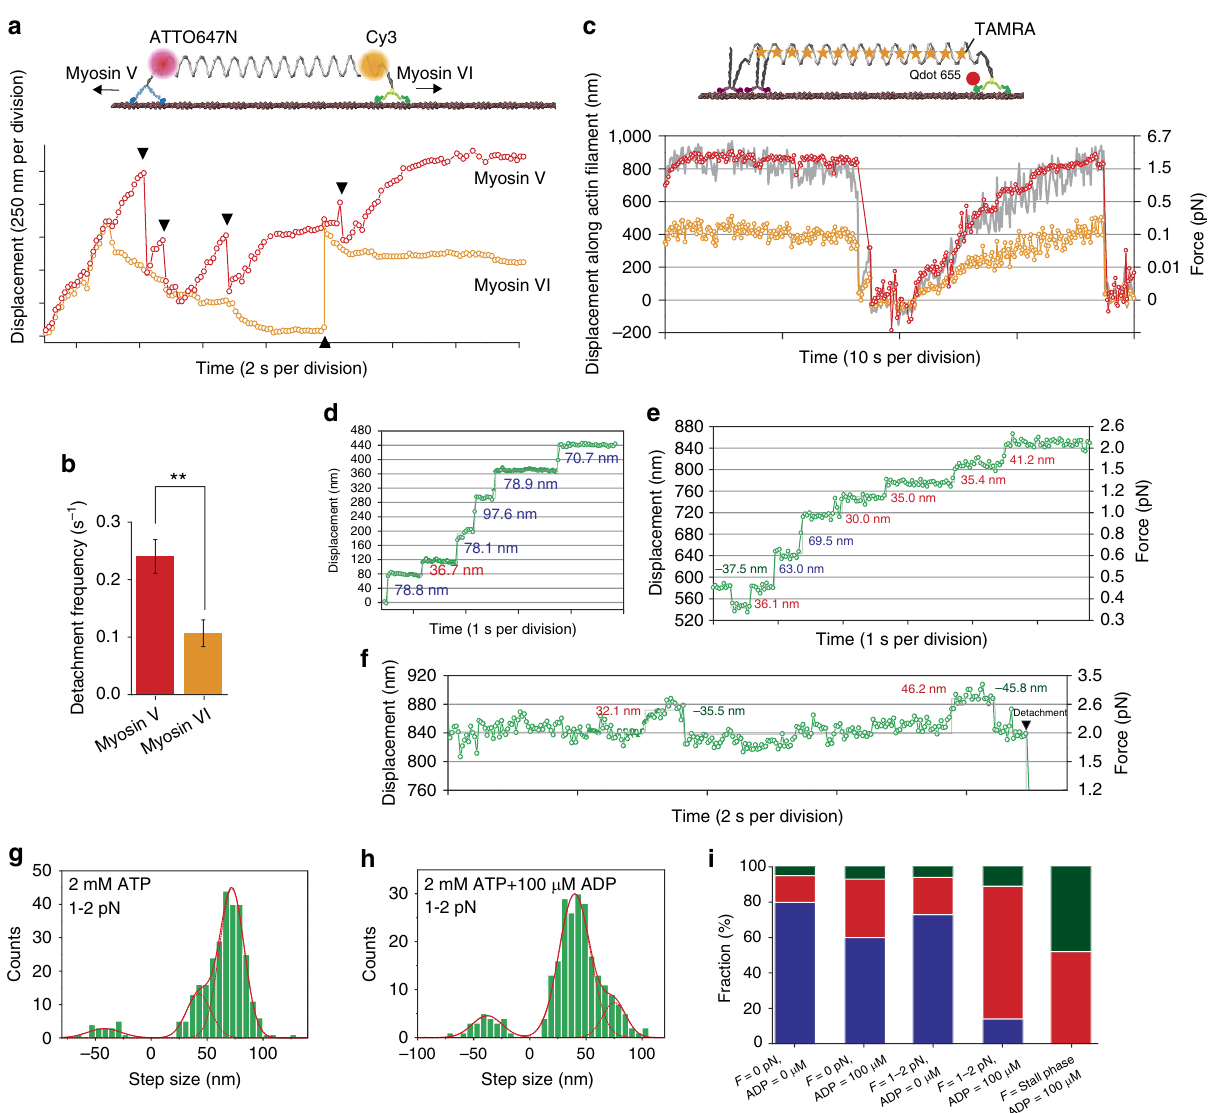
Figure 3 | Dual colour imaging of single-molecule tug-of-war and nanoimaging of myosin VI head domain under load. ( a ) Typical trajectory for dual colour imaging of tug-of-war between myosin V and VI at 2mM ATP þ 100 m M ADP. Red circles, the ATTO647N position, which indicates myosin V motion; orange circles, the Cy3 position, which indicates myosin VI motion. Black triangles indicate detachment events. ( b ) Detachment frequency during tug-of-war for myosin V (red) and myosin VI (orange). Error bars indicate s.e.m. N ¼ 47 myosin-NS complexes, ** P o 0.01 (two-sided t -test). ( c ) Trajectories of a QD (red circles) attached to the head of a myosin VI, the centre position of a TAMRA nanospring (orange circles) and two times the displacement of the centre position of the TAMRA nanospring (grey line) at 2mM ATP þ 100 m M ADP. Recording rate, 10Hz. ( d – f ) Trajectories at 2mM ATP and 0pN ( d ), 2mM ATP þ 100 m M ADP and 0.4-2pN ( e ), and stall force ( f ). Recording rate, 30Hz. The red Gaussian fits in g represent step sizes at 2mM ATP and 1–2pN load ( (cid:2) 41.8 ± 15, 42.5 ± 11 and 72.1 ± 11nm) and in h at 2mM ATP þ 100 m M ADP and 1–2pN load ( (cid:2) 38.0 ± 13, 40.0 ± 13 and 75.3 ± 10nm). Error indicates s.d. ( i ) The distribution of large (blue), short (red) and backward (dark green) steps at different loads and ADP concentrations estimated from the Gaussian